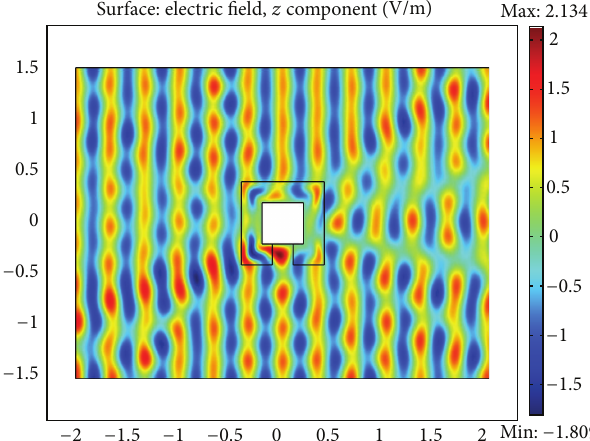
Figure 9: The coverage performance with the gap-existed cloak sit- uation.